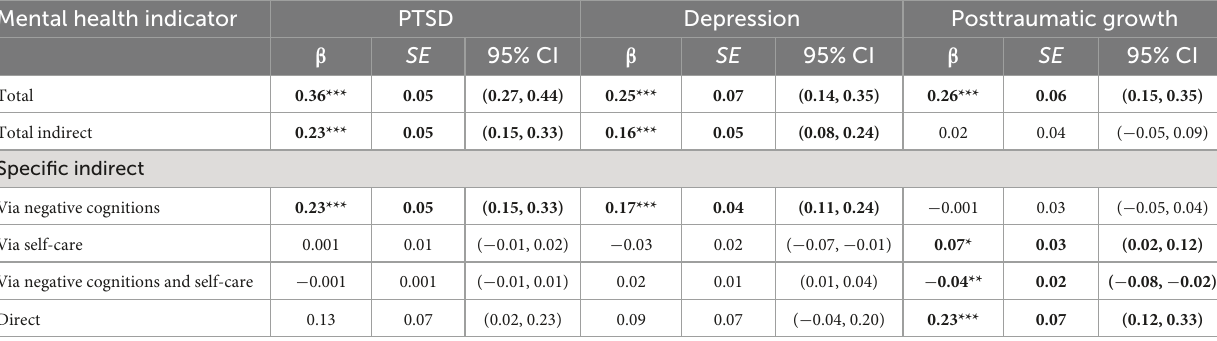
TABLE 2 Total, indirect and direct effects of potentially morally injurious events (PMIE), negative cognitions and self-care on posttraumatic stress disorder (PTSD) symptoms, depression symptoms and posttraumatic growth. Mental health indicator